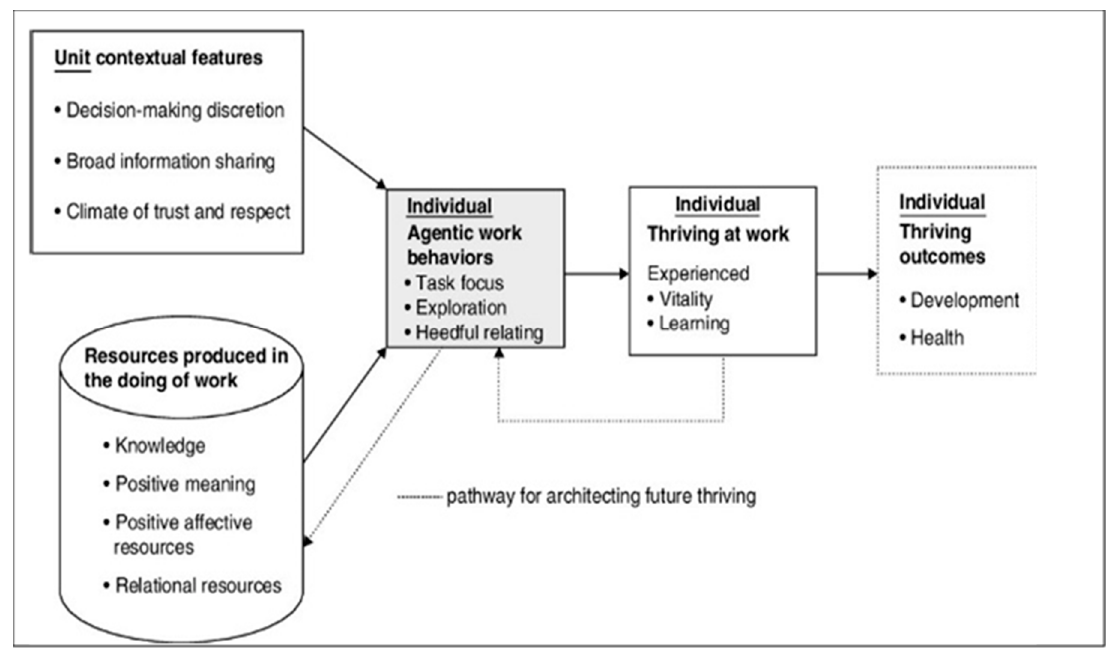
Figure 2. The Social Embeddedness of Thriving at Work Model (Spreitzer et al., 2005).